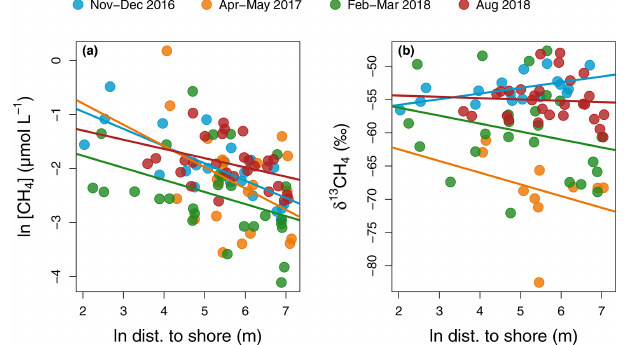
Figure 6. Regression of CH 4 concentration (a) and isotopic sig- nature (b) as a function of distance to shore in each sampling campaign in the main reservoir basin. For CH 4 concentration, re- gressions lines have the following statistics in order of sampling: p values: < 0 . 001, 0.06, 0.03, and 0.05 and R 2 : 0.54, 0.13, and adj 0.11. For δ 13 CH 4 , all regressions had p values > 0.2 except for the November–December 2016 campaign with a p value = 0.01 and = 0 . R 2 adj